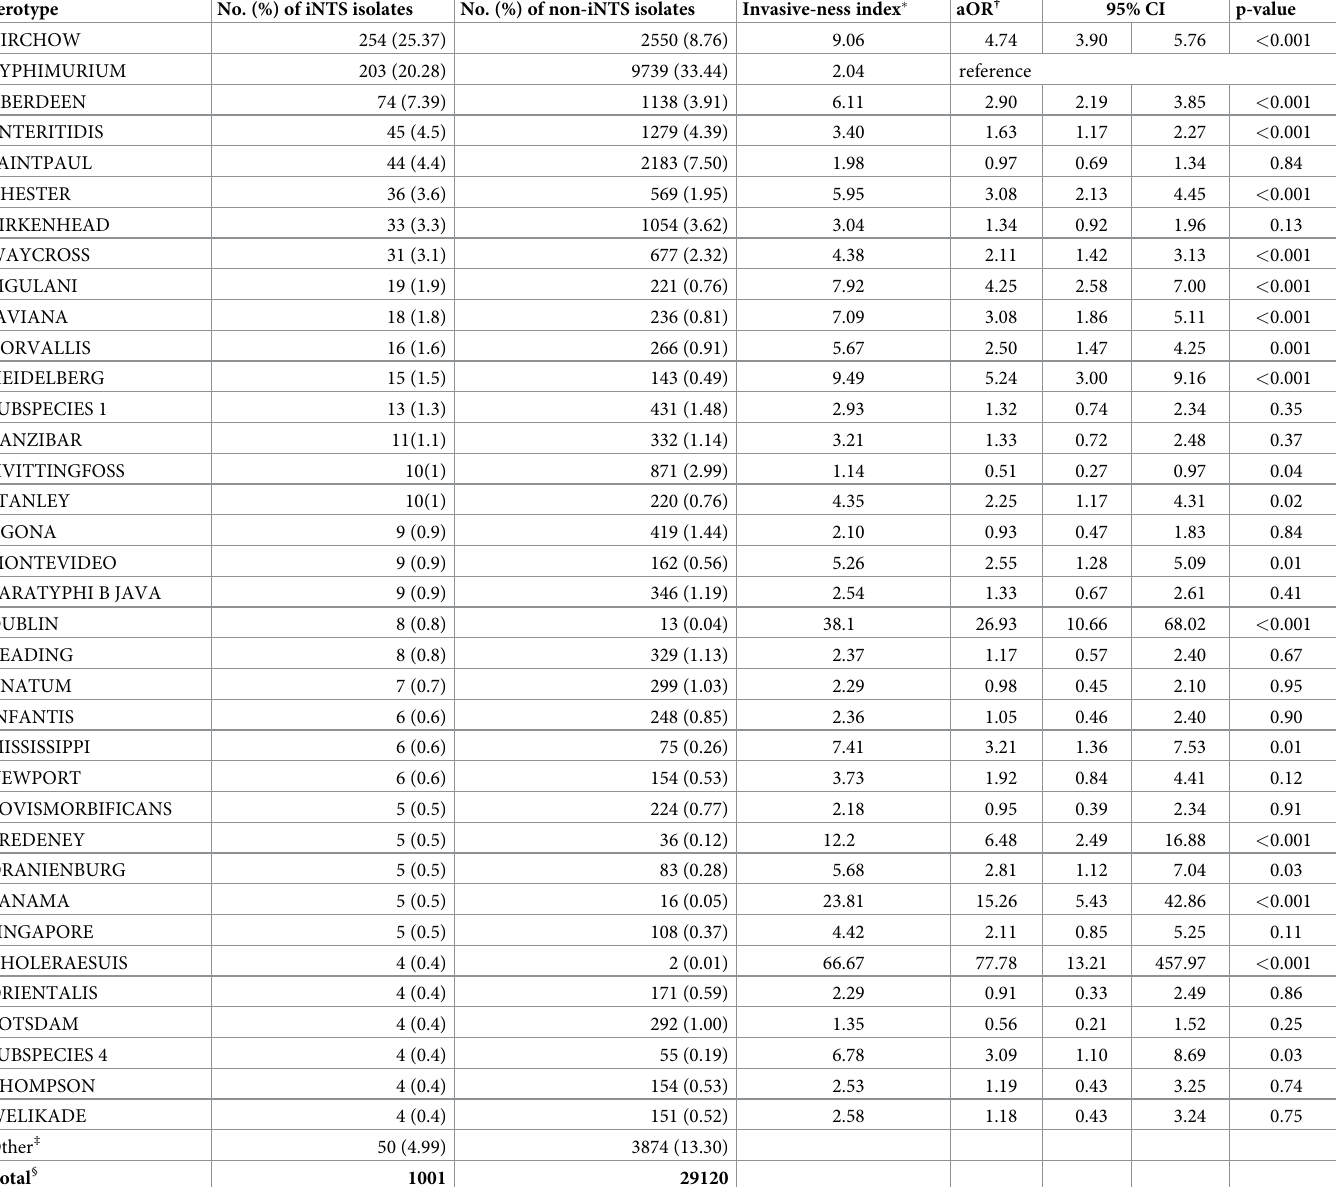
Table 1. Distribution and invasiveness of most common iNTS serotypes in Queensland,